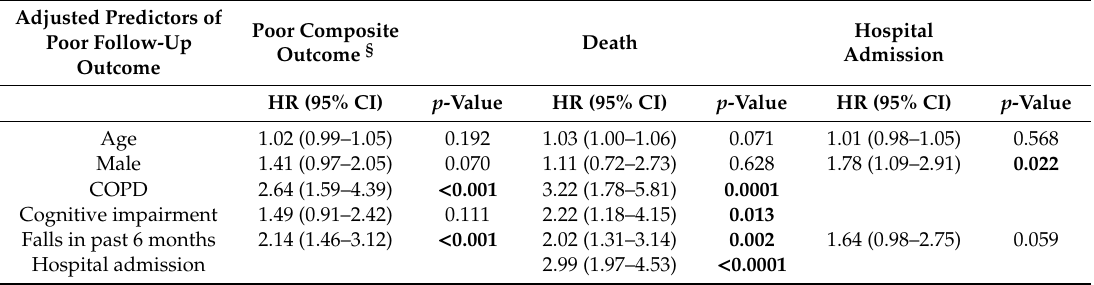
Table 3. Adjusted associations between predictors and poor composite outcome. Final Cox regression models for 3 di ff erent